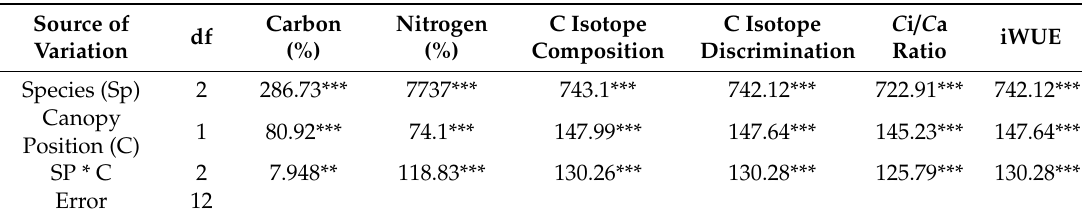
Table 3. Results of two-way ANOVA (F-values) testing the effects of Prosopis species ( P. juliflora , P. pallida , and P. cineraria ) and canopy position (east and west) on carbon (%), nitrogen (%), carbon isotope discrimination, and intrinsic water-use efficiency (iWUE) of young leaves of the three Prosopis species in the non-saline habitat.